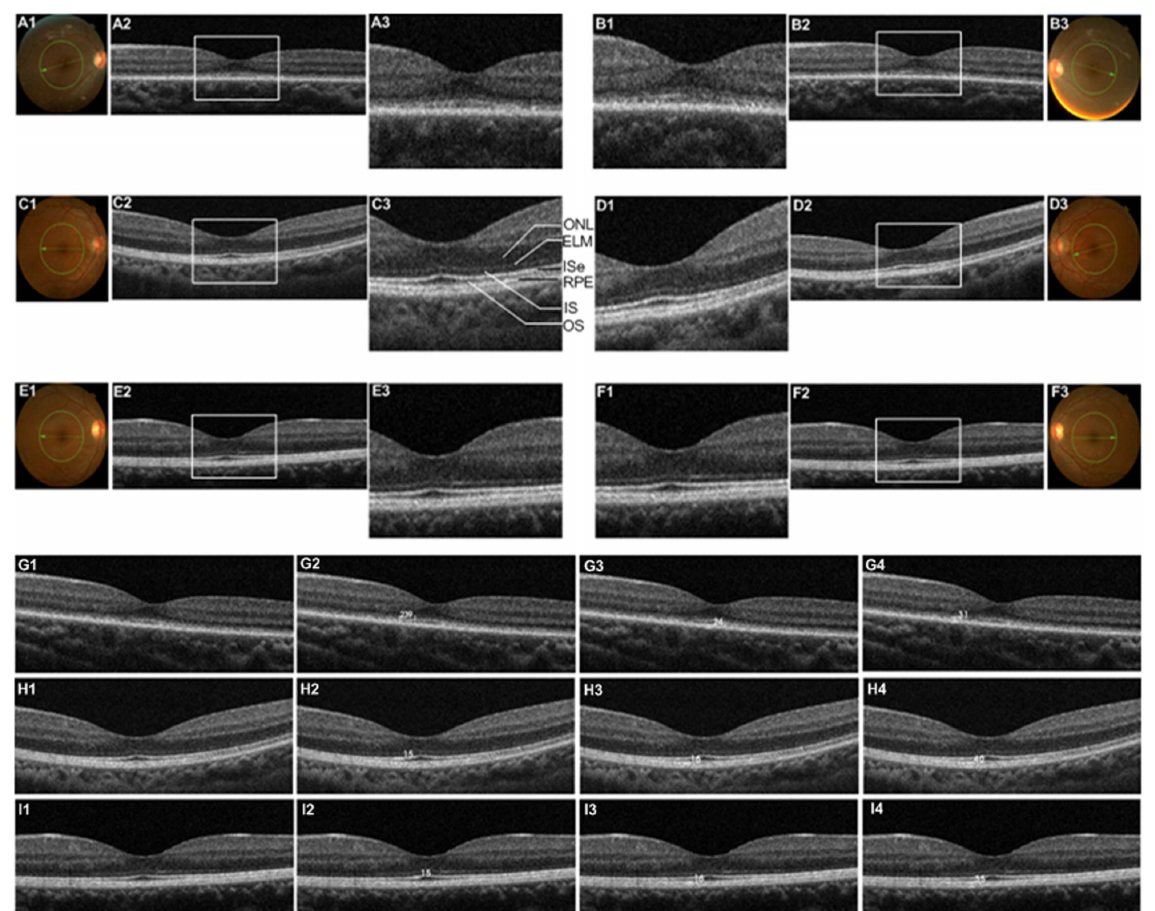
Figure 3. Foveal spectral-domain optical coherence tomography (SD-OCT) recordings of eyes in the whole family. The green circle in fundus photographies (a-1, b-3, c-1, d-3, e-1, and f-3) shows the scanning position of the presented SD-OCT recordings of the family using 3D macular protocol. Foveal SD-OCT pictures of the patients (a-2 and b-2) show abnormalities of retinal stratification including extremely thinned ONL (outer nuclear layer), heavily thinned RPE (retinal pigment epithelial) layer, altered photoreceptor layers (ELM, IS, ISe, and OS). The patient’s grayscale SD- OCT recordings (a-2, and b-2) show that the boundaries of ELM, IS, ISe and OS layers are not well demarcated and the ISe layer could hardly be discerned. The white box in grayscale SD-recordings (a-2, b-2, c-2, d-2, e-2, and f-2) indicates the area of enlargement. The enlargement of grayscale SD-OCT recordings at the fovea of both eyes (a-3, and b-1) show that the ELM, IS, ISe and OS layers are not continuous. The abnormalities of retinal stratification are not present on the foveal SD-OCT recordings of her father (c and d) or mother (e and f). We measured the thickness of ISe, RPE, and RPE-choroid of the patient and her parents’s right eyes (Figure 3g, 3h, and 3i). Her father/mother’ results were 15 m m/15 m m (Figure 3h-2 and 3i-2), 16 m m/16 m m (Figure 3h-3 and 3i-3), and 40 m m/35 m m (Figure 3h-4 and 3i-4). Because the boundaries of IS, ISe, OS, and RPE are not clear, we measured the noncontiguous area of ISe layer, RPE-choroid and ISe-choroid,and the results were 239 m m (Figure 3g-2), 24 m m (Figure 3g-3), and ISe- choroid (Figure 3g-4),